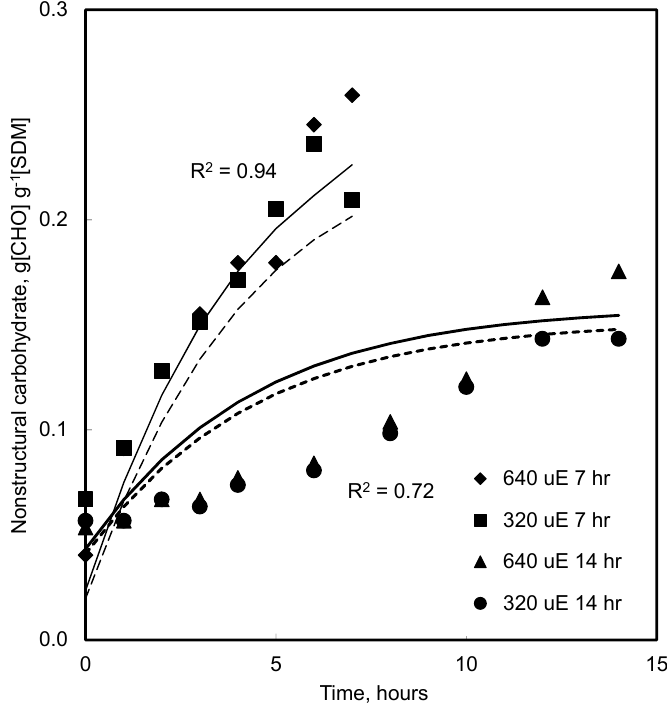
Figure 8. Non ‐ structural carbohydrate content of “Amsoy” soybean grown under 7 ‐ or 14 ‐ h day Figure 8. Non-structural carbohydrate content of “Amsoy” soybean grown under 7- or 14-h day lengths and 320 or 640 μ mol[PAR] m − 2 s − 1 [27]. Symbols are data and lines are predictions of the lengths and 320 or 640 µ mol[PAR] m − 2 s − 1 [27]. Symbols are data and lines are predictions of the dynamic model. dynamic